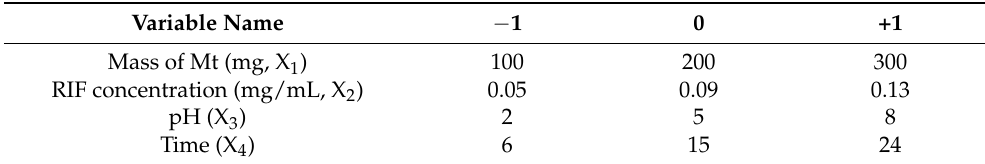
Table 1. Values used in the CCD to evaluate four operational variables for the evaluation of the RIF incorporated process in